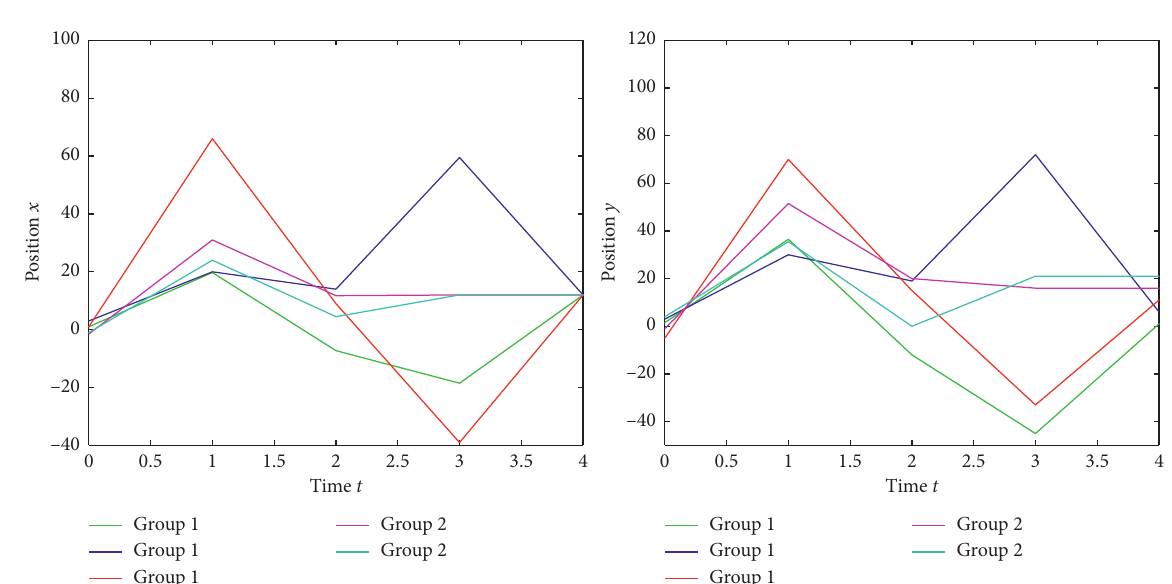
Figure 5: The time-evolution trajectories for the x − axis and y − axis corresponding to Figure